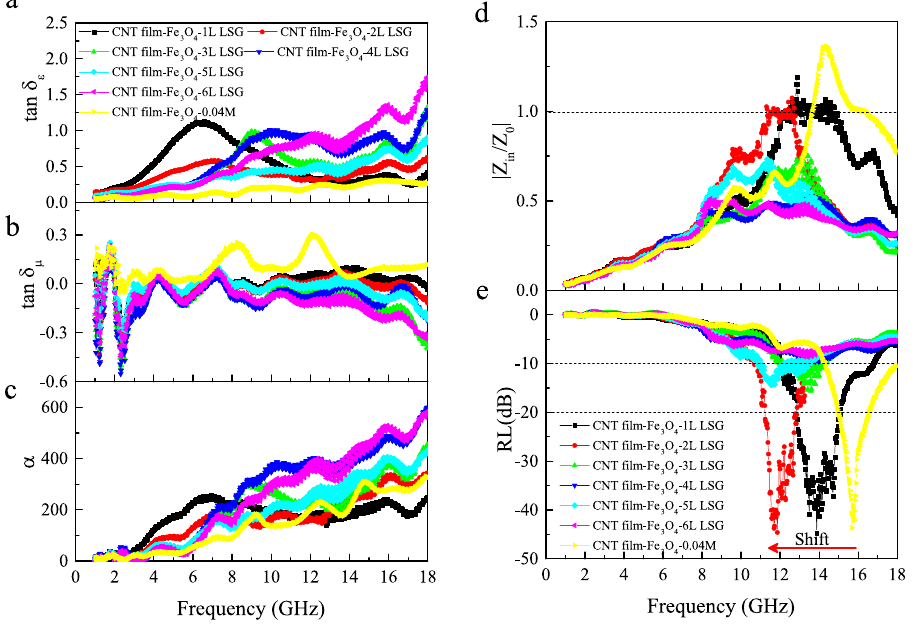
Figure 5. ( a ) Dielectric tangent loss, ( b ) magnetic tangent loss, ( c ) attenuation constant, ( d ) impedance matching coefficient |Z in /Z 0 | and ( e ) reflection loss of the CNT film-Fe 3 O 4 -0.04 M-LSG composites with one, two, three, four, five and six layers of